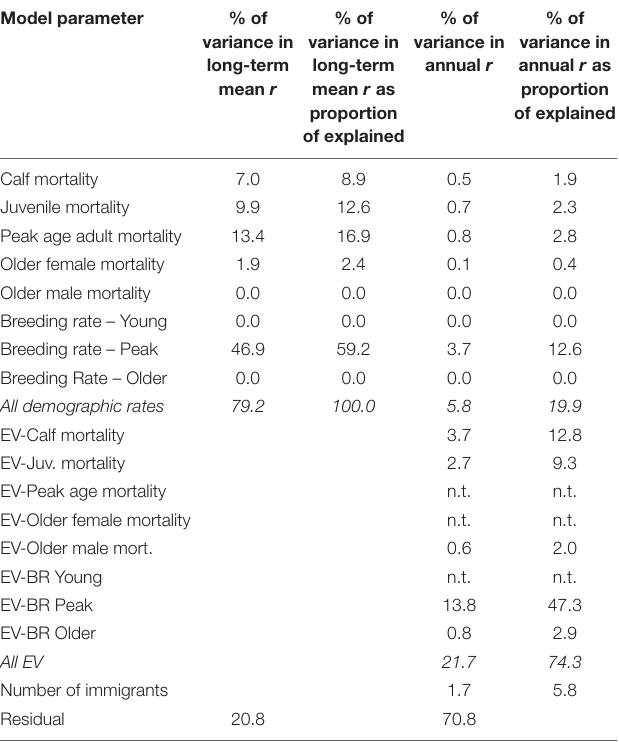
TABLE 6 | Partitioning of variance in projected population growth ( r ).